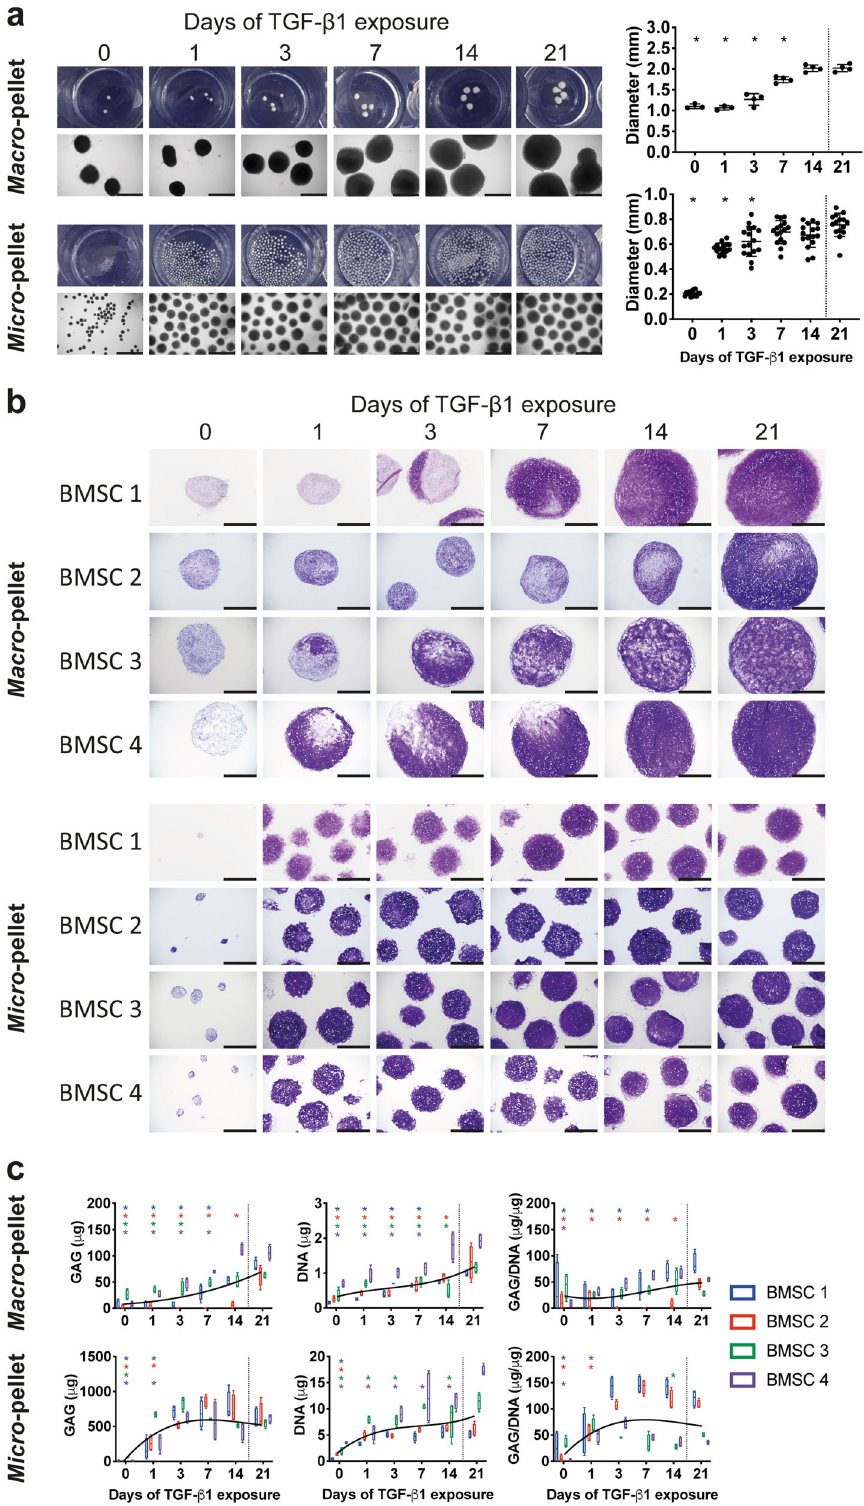
Fig. 2 Cartilage-like tissues derived from BMSCs after 21 days in vitro differentiation with TGF- β 1 exposure for the number of days indicated. a Gross photographs and bright fi eld microscopy images of whole BMSC-derived tissues (scale bars for microscopy images, 1 mm), and corresponding diameters. b Toluidine blue stain of glycosaminoglycan (GAG) matrix in macro - and micro -pellet tissue cross-sections are shown for four unique BMSC donors (scale bars, 500 μ m). c GAG, DNA, and normalized GAG/DNA quanti fi cation for each BMSC donor. Asterisks are shown for values that are signi fi cantly lower than the corresponding 21 days of TGF- β 1 exposure control. Box plots: n = 4 for each donor; * P <